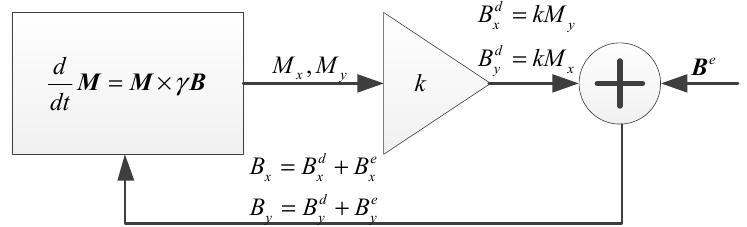
Figure 2. Simulation model corresponding to the NMRG principle given in Figure 1.